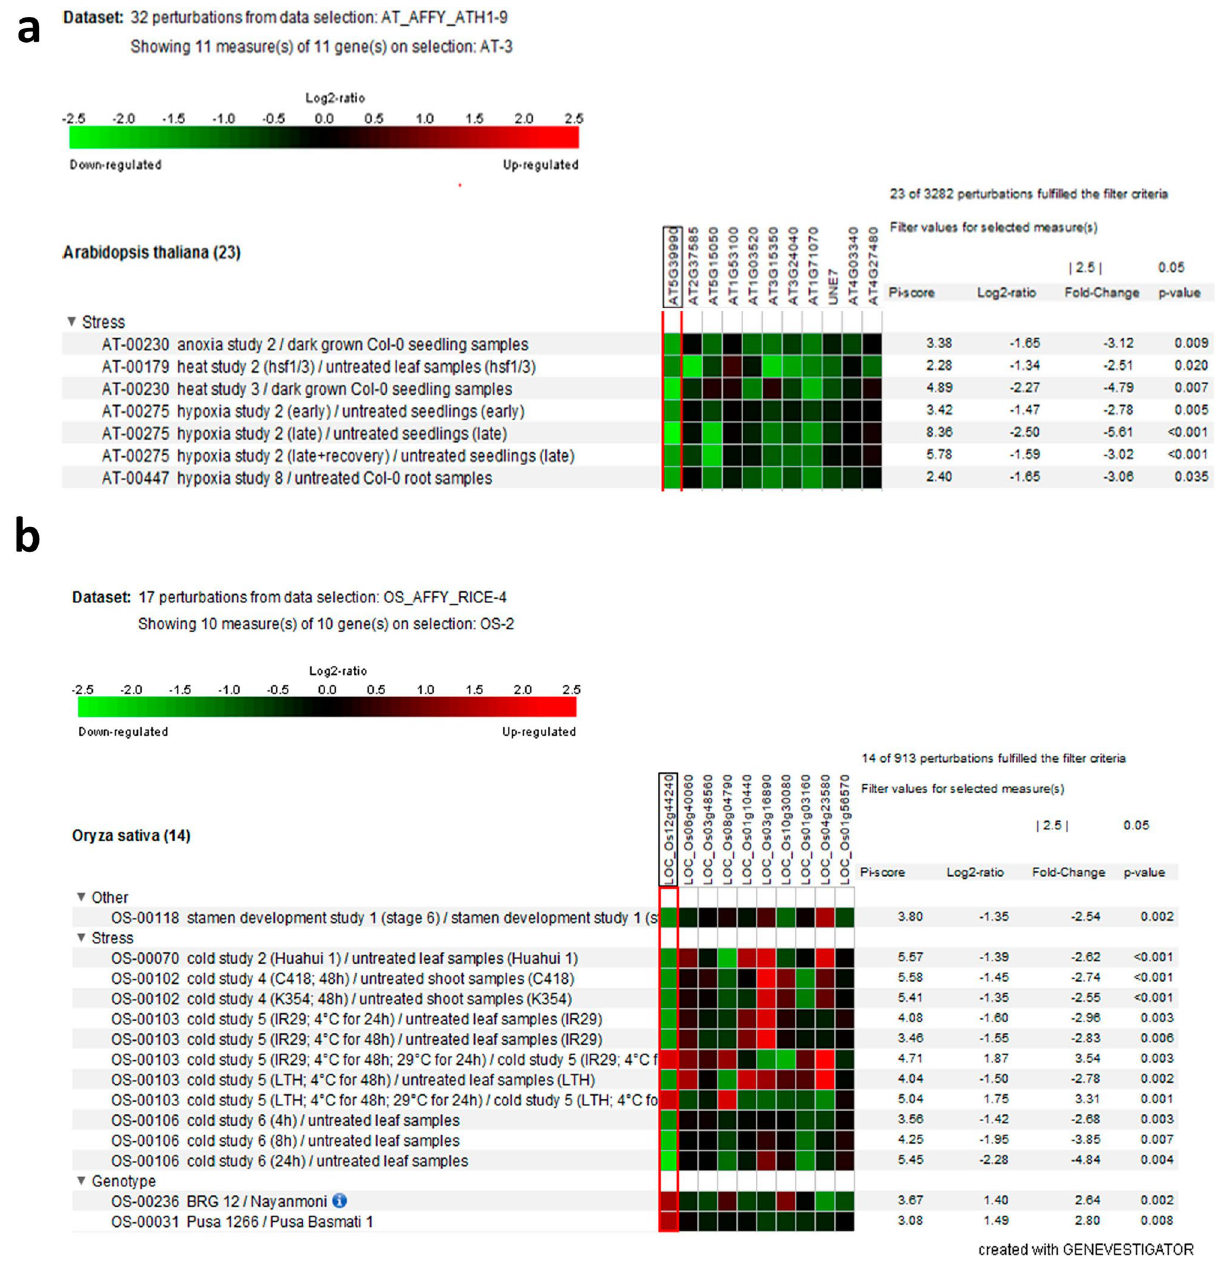
Figure 7. Expression pattern of putative GLCATs genes in Arabidopsis and rice in response to abiotic stress. ( a ) Expression pattern of GLCAT genes in Arabidopsis thaliana during anoxia, heat and hypoxia ( b ) Expression pattern of GLCAT genes in rice during cold stress. Note the differential gene expression in all GLCATs in Arabidopsis and rice in response to different stressors. The red boxed region indicates AtGlcAT14A (AT5g39990) and its ortholog in rice, both of which are relatively down-regulated in response to